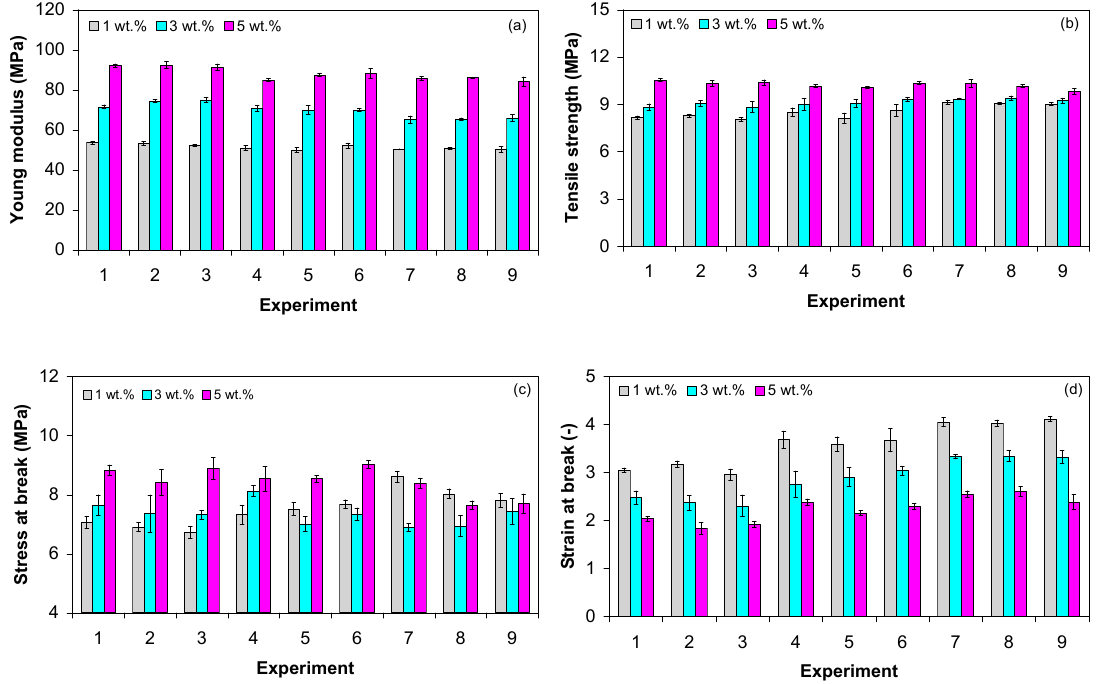
Figure 11. Mechanical properties of EVA / MWCNT composite: ( a ) Young modulus, ( b ) tensile strength, ( c ) stress at break, and ( d ) strain at break at 50 mm/min.